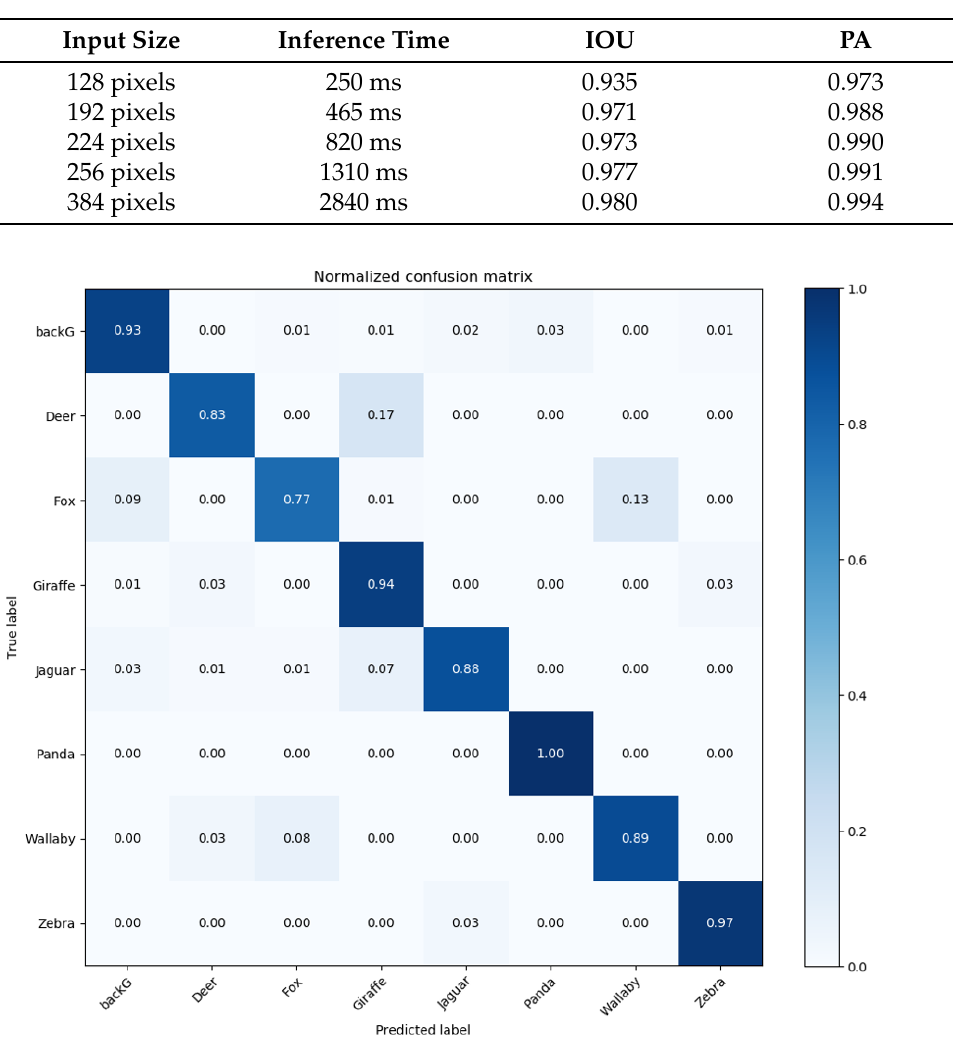
Table 1. Performance of our network implanted on Note 9 with different input sizes.